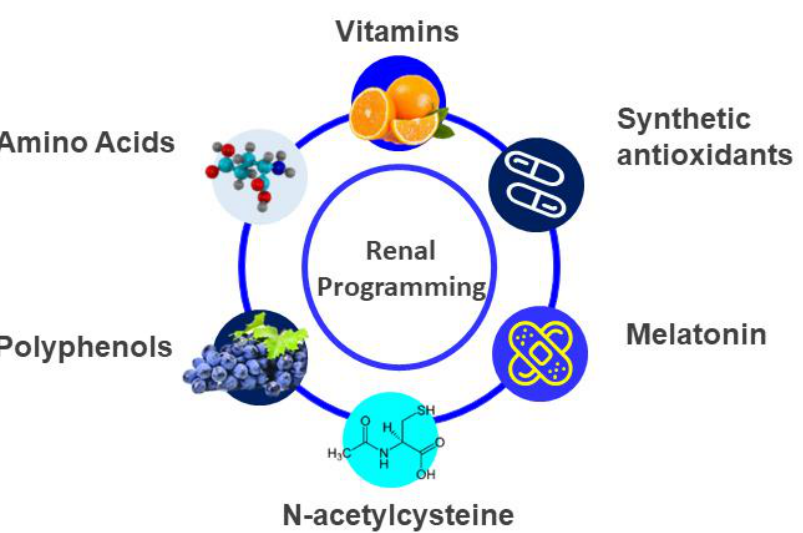
Figure 3. Diagram outlining a potential antioxidant strategy to prevent adult-onset kidney diseases.